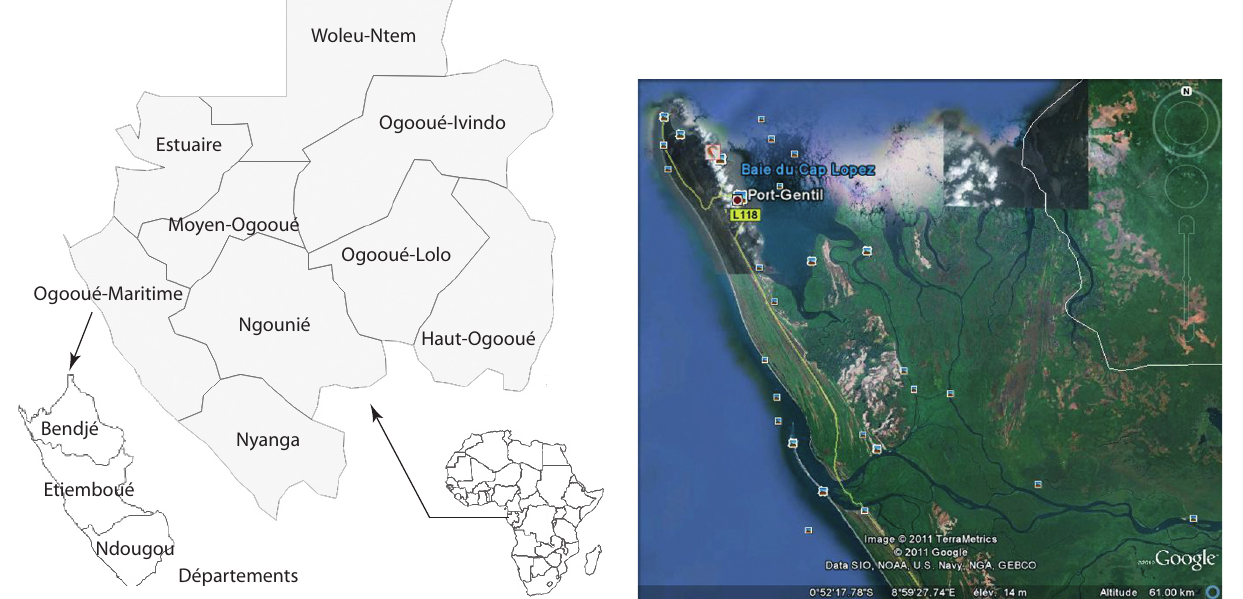
Fig. 2. – Image satellitaire de la zone d’étude (Google Earth – earth. google.com).Fig. 1. – Le Gabon et le département de Bendjé dans la province